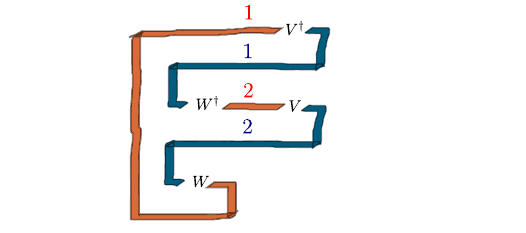
FIG. 2. Representation of the OTOC h “ path integral ” involving four layers. Each layer corresponds to one of the unitary time evolution operators (blue, U ; red, U † ) appearing in the correlator. These unitaries are given by a realization of the random circuit, and averaging over them gives rise to interactions between different layers.